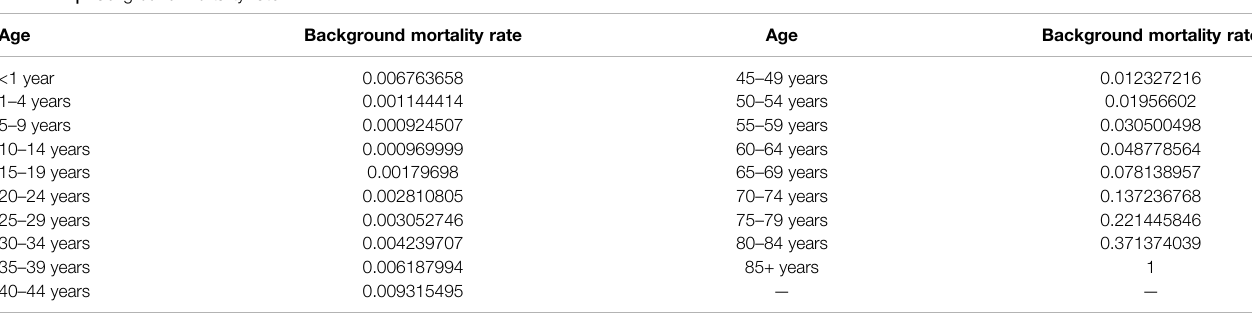
TABLE 2 | Background mortality